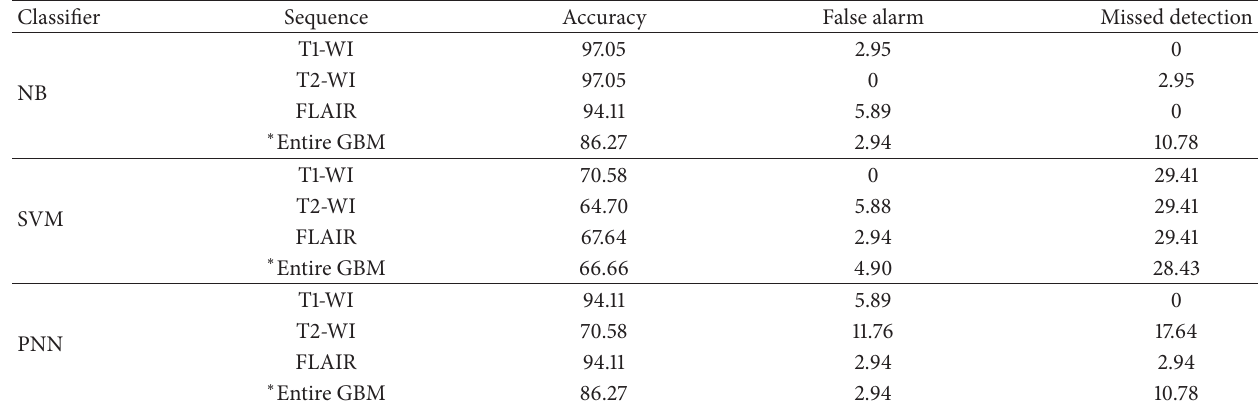
Table 1: Performance metrics (%) based on the GMM features.